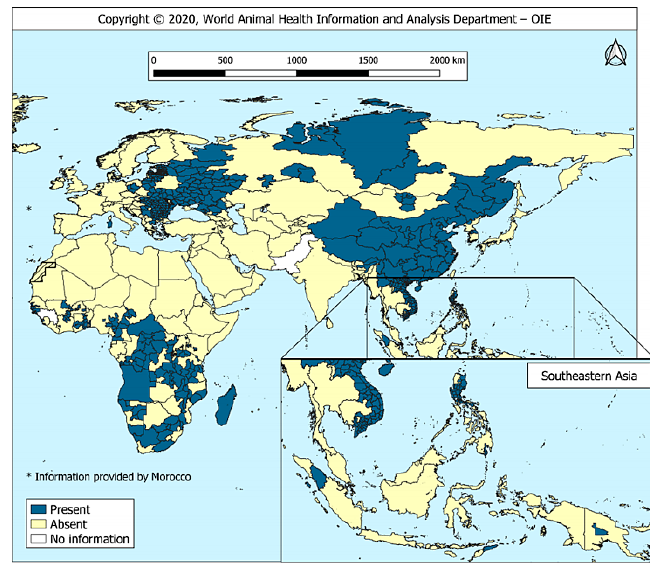
Figure 1. Global situation of ASF, Source: OIE, (2016–2020) [16].